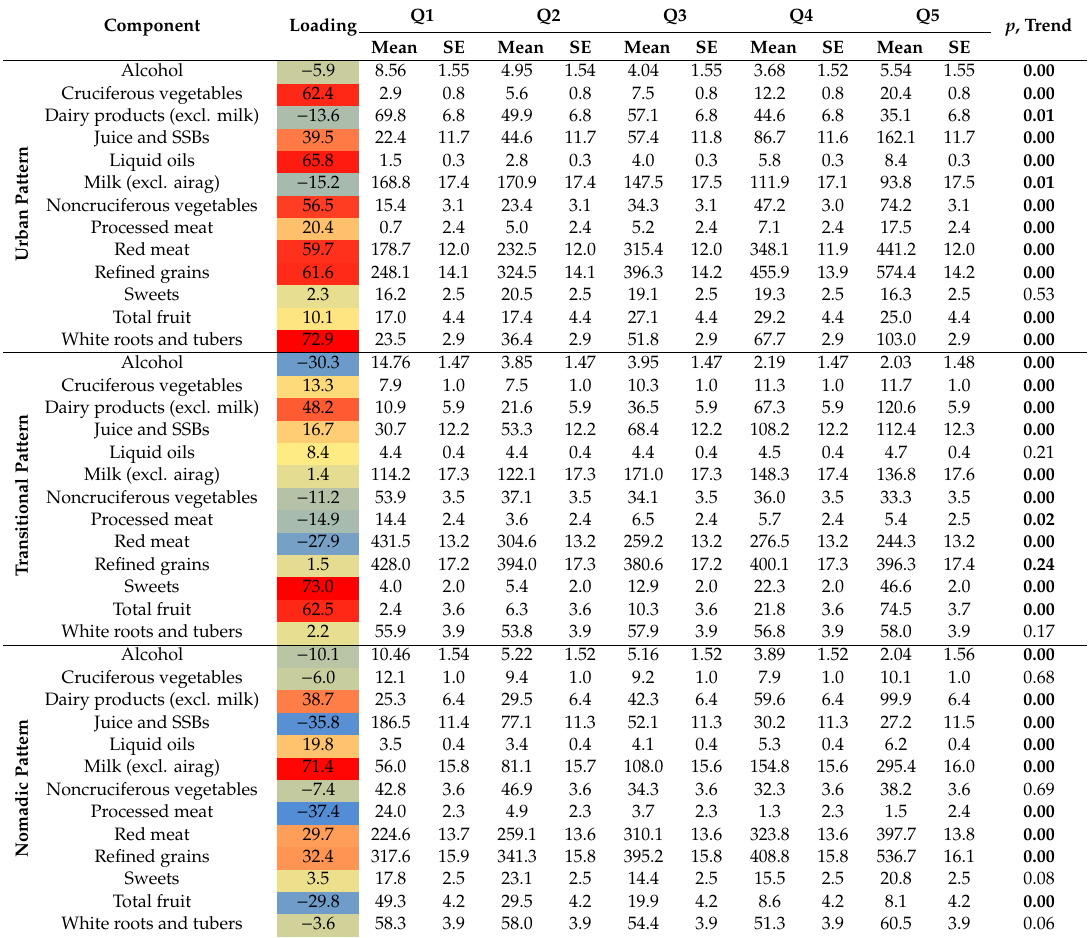
Table 6. Diet pattern factor loadings and mean intake (g / day) of pattern components by quintile of pattern